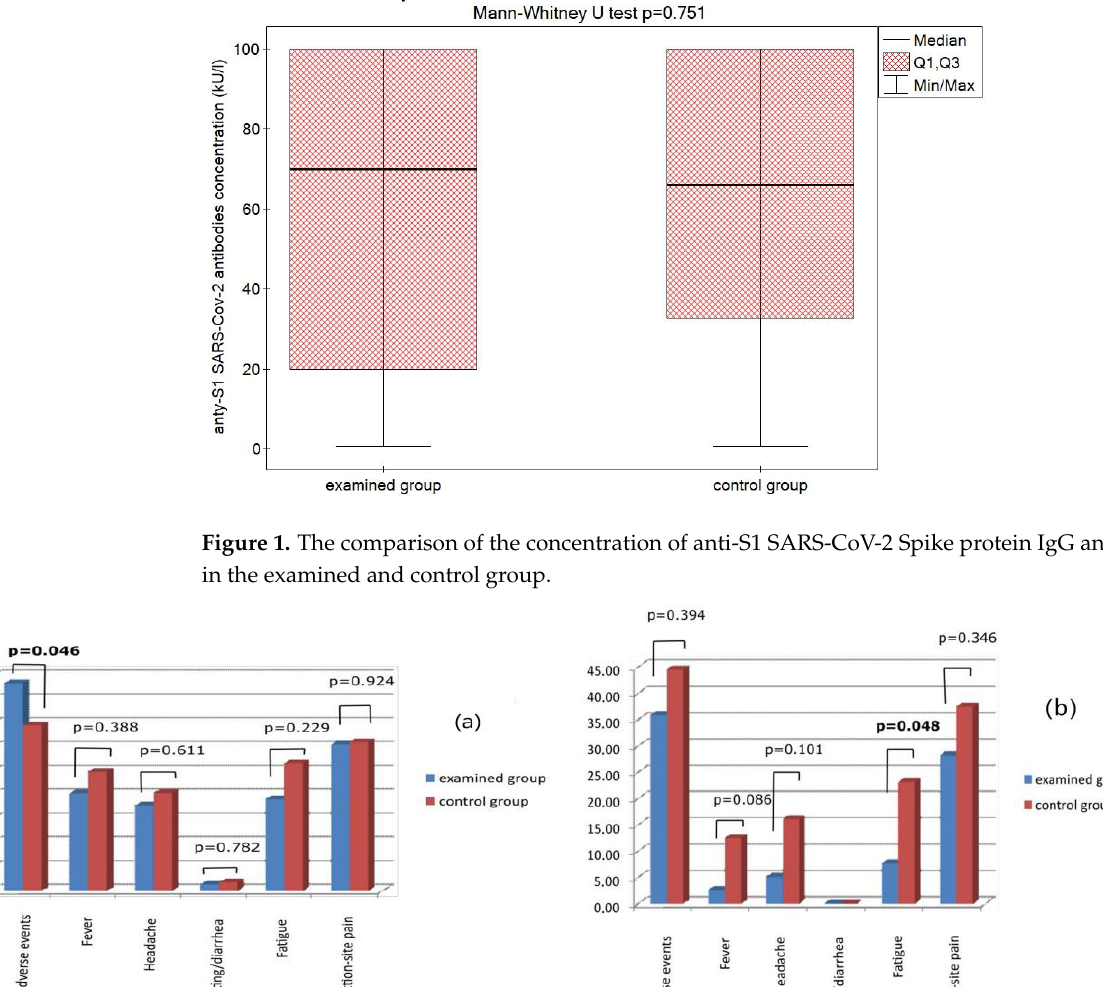
Figure 1. The comparison of the concentration of anti-S1 SARS-CoV-2 Spike protein IgG antibodies in the examined and control group.